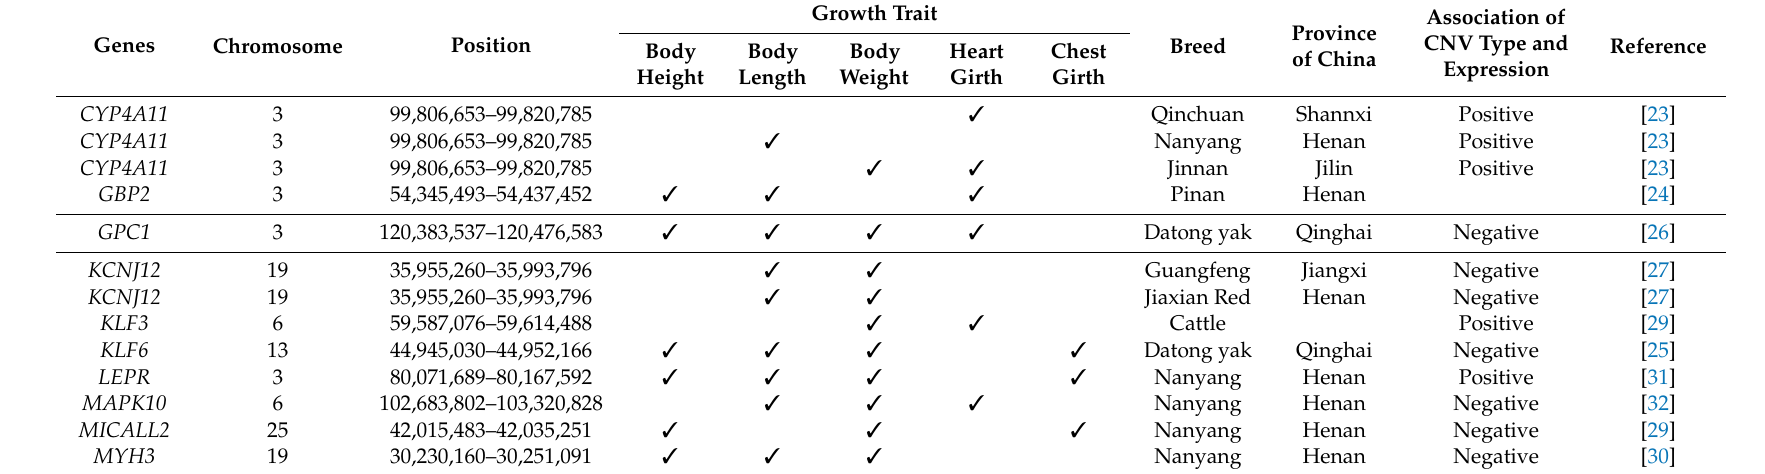
Table 5. Identified candidate CNV-related genes associated with growth traits of cattle from other studies.